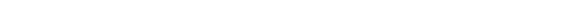
Fig. 2 The phototropic response of S299A mutants is less sensitive to increased fl uences. a , b Phototropism time course of 3-day-old etiolated seedlings of pks4 WT-2 and pks4 S299-A2 treated with 0.1 or 10 µ mol m − 2 s − 1 lateral blue light for the indicated time. n = 15 − 29, data represent means, error bars correspond to 2× standard error. c Phototropic curvature of 3-day-old etiolated seedlings of Col-0, pks4 , pks4 WT-2, and pks4 S299-A2. Seedlings were exposed to two 10 min pulses of unilateral blue light at either 0.03 or 3 µ mol m − 2 s − 1 , separated by 50 min of darkness. One hour prior to the fi rst blue light pulse plants were treated for 1 min with 30 µ mol m − 2 s − 1 red light to enhance the phototropic response by activating phytochromes. After the second pulse plants were kept in darkness for 3 h prior to measurement of growth re-orientation. n = 15 − 20, data represent means, error bars correspond to 2× standard error, means with same letter are not signi fi cantly different ( p > 0.05, two-way ANOVA